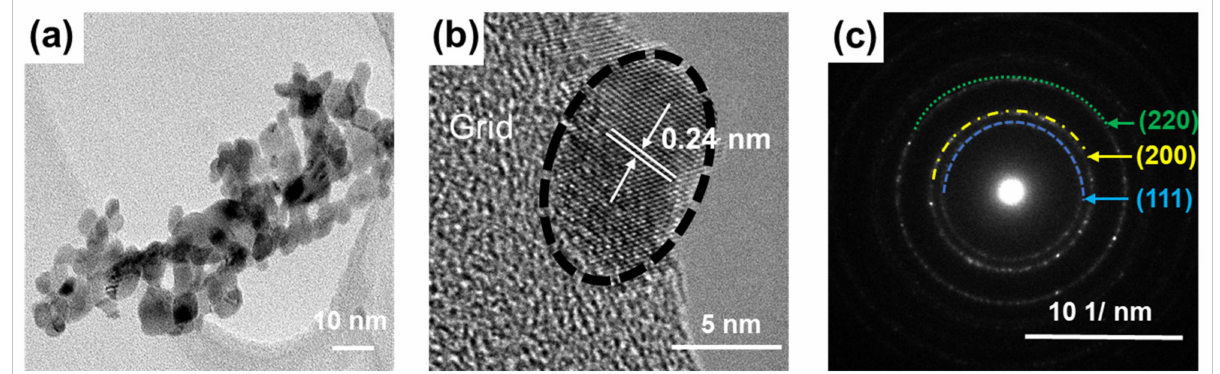
Figure 1. Transmittance electron microscopy (TEM) image ( a ), high-resolution TEM (HR-TEM) image ( b ), and selective-area electron diffraction (SAED) pattern ( c ) of the NiO x